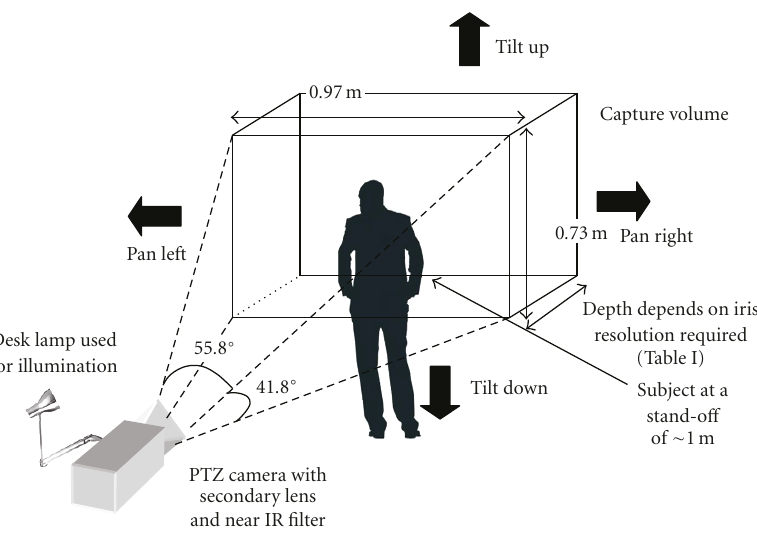
Figure 7: This figure shows the system that we setup. It consists of the axis 233D pan-tilt-zoom camera along with a table lamp with a standard 100 W bulb for illumination. The capture volume indicated is limited in depth by the pixel iris resolution required. Because of the autofocus mechanism, even at a fixed zoom level, which is 119mm in our work, the person can come upto 0.5 meters in front of the lens. The arrows indicate how the volume can move based on the pan-tilt motion of the camera. The field of view of the camera is 55 . 80 × 41 . 80, which is approximately 0 . 97 × 0 . 73 meters at a subject stand-o ff of 1